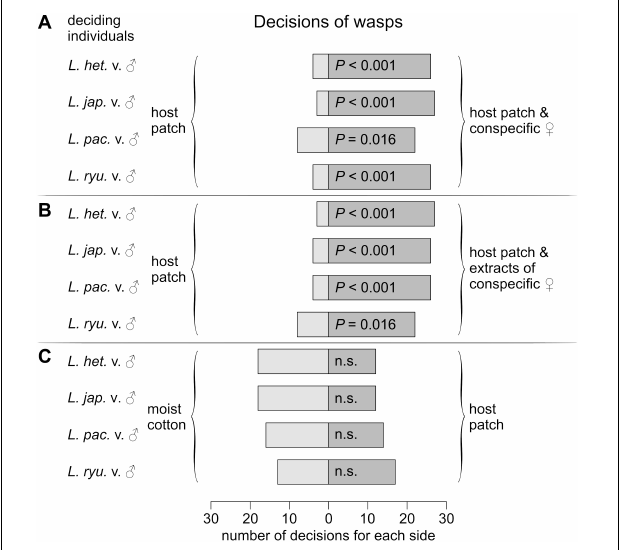
FIGURE 7 | Frequency of decision for control (light gray bars) or sample (dark gray bars) of virgin females of L. heterotoma , L. japonica , L. pacifica , or L. ryukyuensis in a Y-tube experiment with a choice between the odor of unexploited host patches or (A) host patches with 20 conspecific males or (B) clear humidified air provided by moist cotton pads, (C) Decisions of mated females of each of the species when choosing between the odor of unexploited host patches or clean humidified air. P -values are given for two-sided binomial tests. For each experiment, N = 30. L. het. = Leptopilina heterotoma , L. jap. = Leptopilina japonica , L. pac. = Leptopilina pacifica , L. ryu. = Leptopilina ryukyuensis , v. = virgin, m. = mated, n.s. = not